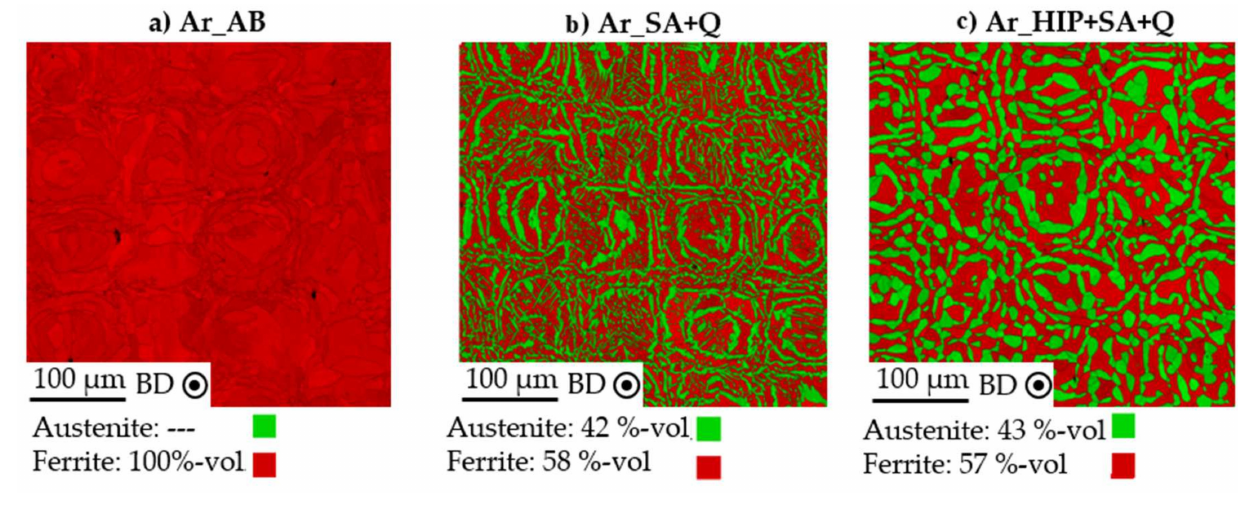
Figure 12. EBSD phase maps of L-PBF AISI 318LN processed under an argon protective atmosphere: